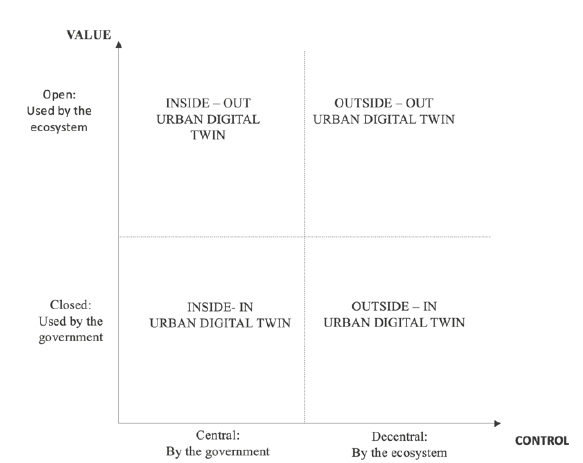
Figure 1. Urban Digital Twin business model